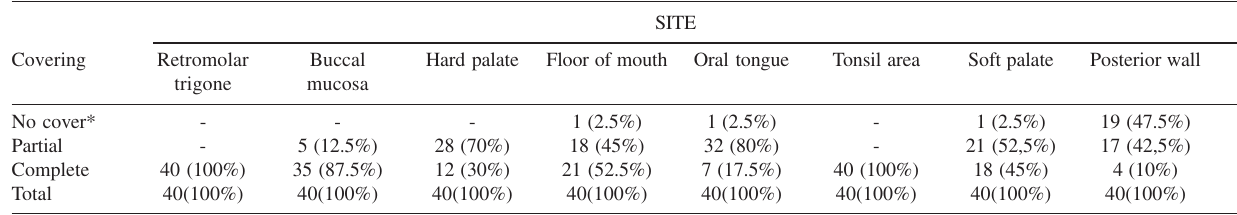
Table 2 - Galeal flap covering (partial or complete) among oral cavity and oropharyngeal sites. Best results achieved in retromolar trigone, buccal mucosa and tonsil area (bold). N =